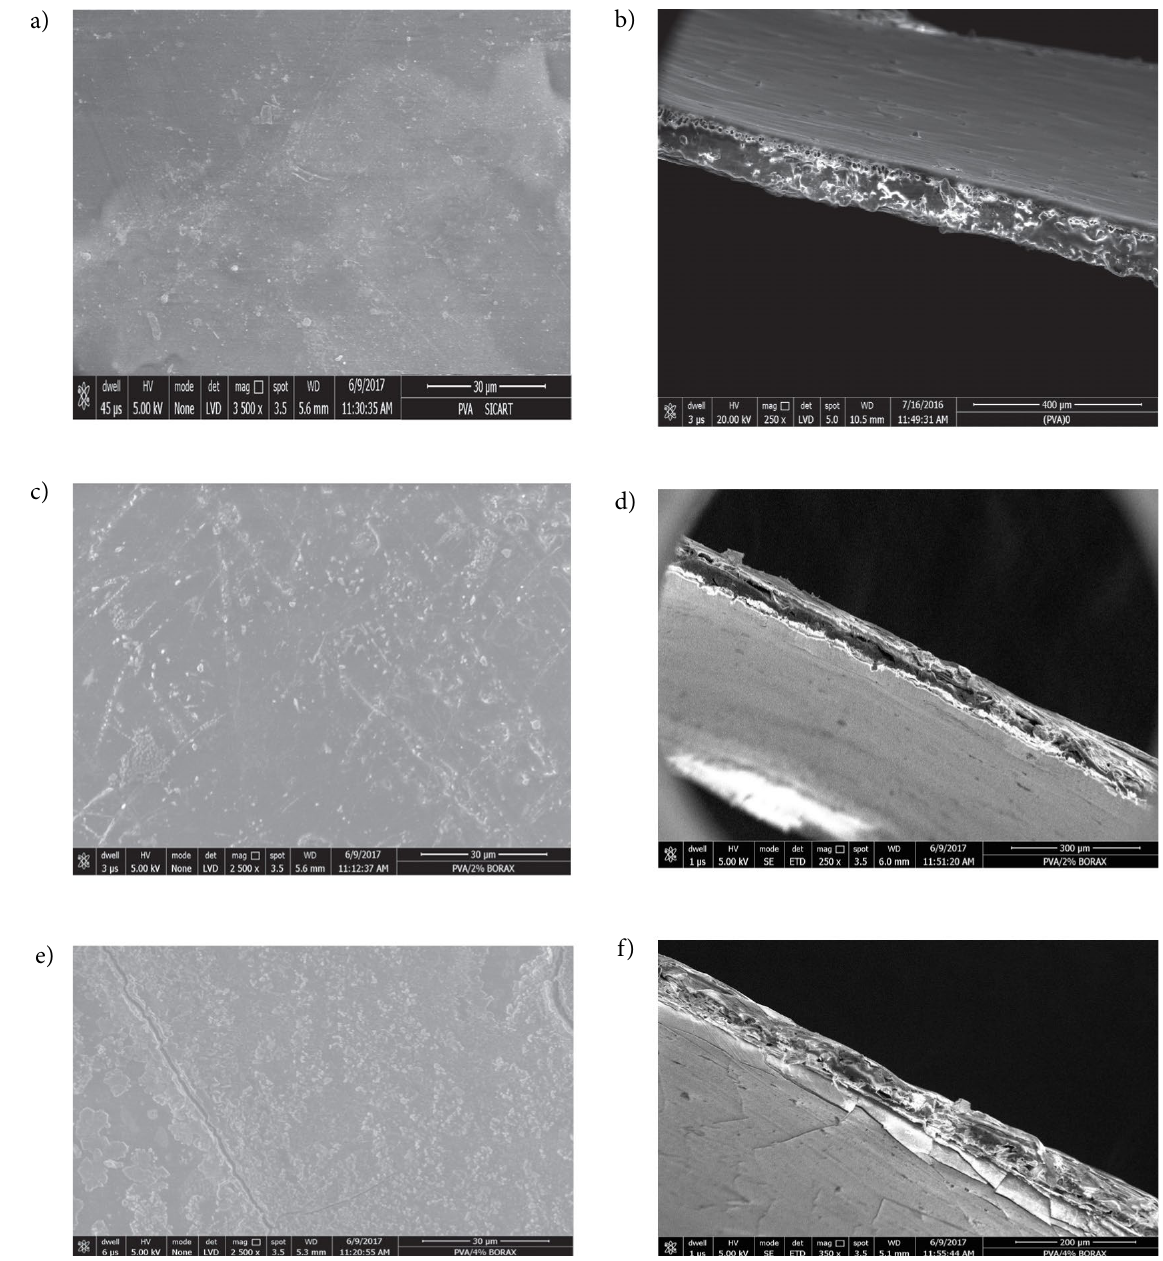
Fig. 6. Scanning electron micrographs of the top surface and cross sections of the uncrosslinked PVA-PES composite, and PVA-PES composite membrane specimens doped with 0.2% and 0.5% of borax crosslink (a: uncrosslinked PVA –PES top surface, magnification: 3500; b: uncrosslinked PVA-PES cross section, magnification: 250; c: PVA-PES-0.2% borax top surface, magnification: 2500; d:PVA-PES-0.2% borax cross section, magni- fication 250; e: PVA-PES-0.5% borax top surface, magnification: 2500; f: PVA-PES-0.5% borax cross section, magnification: